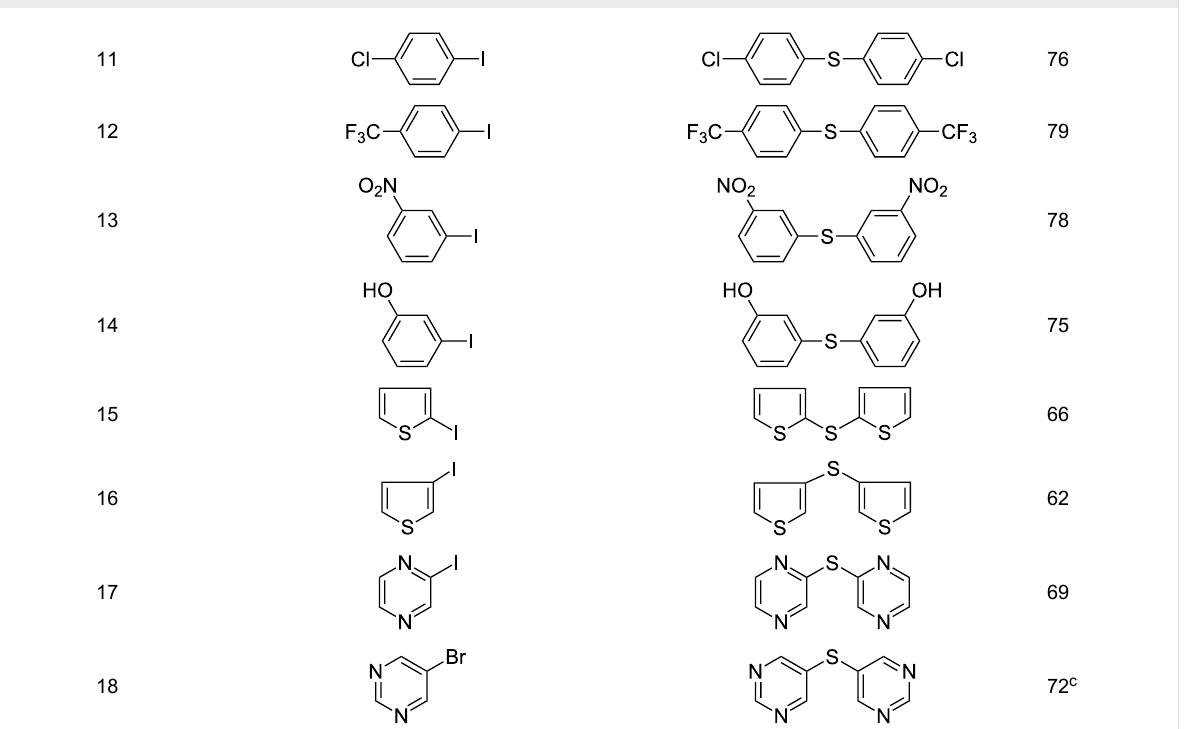
Table 3: Copper oxide nanoparticles catalyzed synthesis of diaryl sulfides a . (continued)